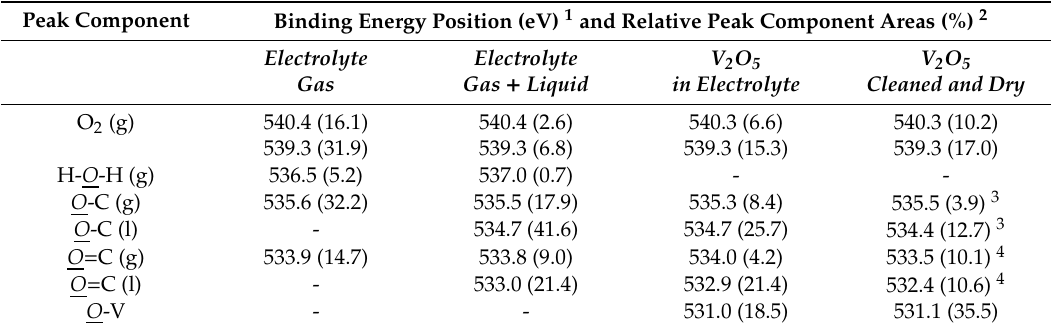
Table 2. Peak fit results of O 1s core-level spectra from LP30 electrolyte as shown in Figure 2. Peak